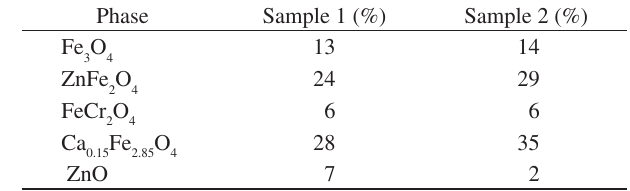
Table 6. Q�a�tificatio� o� �erro�s i� the oxide phases prese�t i� the EAFD samples accordi�� to the Möss�a�er spectroscopy.